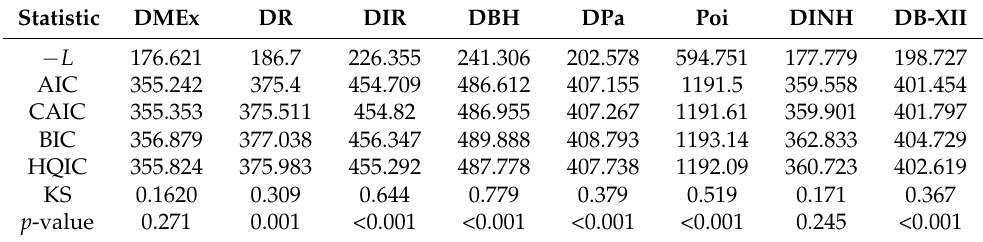
Table 15. The GOF test for COV-P data.